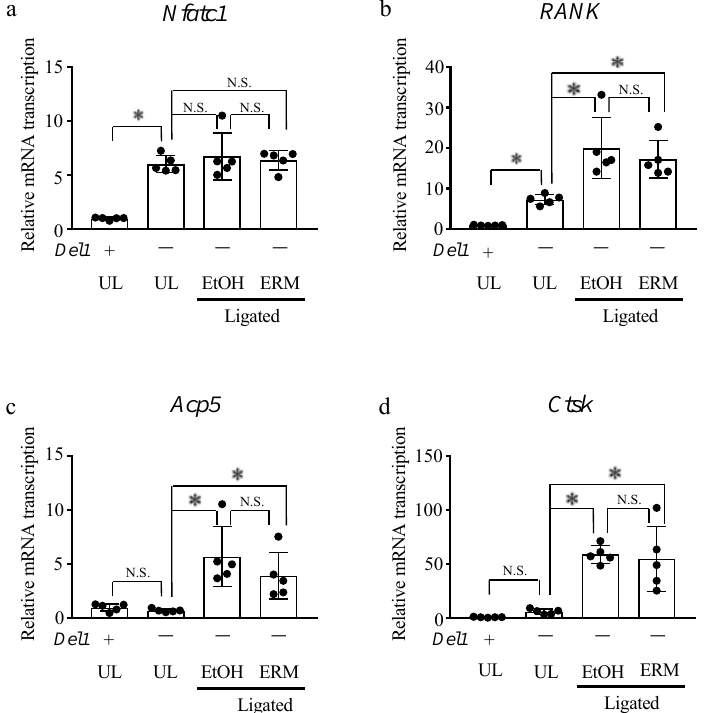
Figure 4. Erythromycin fails to inhibit bone resorption in Del1 -/- mice. Periodontal bone loss was induced in Del1 -/- mice. The unligated (UL) group was set as the baseline control. Groups of mice after tooth ligation were administered intraperitoneally with 20% ethanol (EtOH; control), penicillin (PC), josamycin (JSM), or erythromycin (ERM). ( a ) The distance from the cement enamel junction to the pinnacle of the alveolar bone was measured. Negative values (in mm) indicated bone loss relative to the UL control. ( b ) Representative images of mouse maxillary bones from the indicated groups (scale bars, 0.5 mm). * p < 0.05, compared to the indicated group, means ± SD ( n = 5 per group). N.S., not significant.